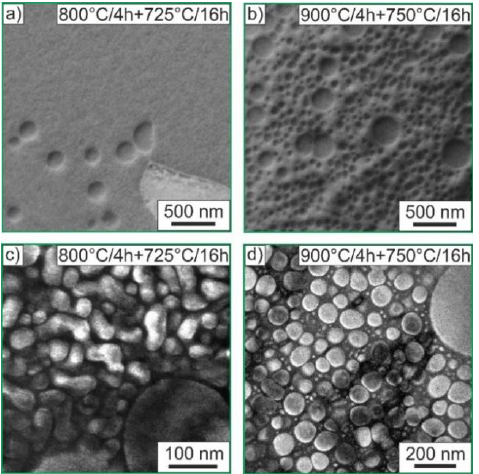
Figure 3. SEM images of the conditions after aging step II: ( a ) 800 °C/4 h + 725 °C/16 h and ( b ) 900 °C/4 h + 750 °C/16 h. Dark field TEM images of the conditions after aging step II: ( c ) 800 °C/4 h + 725 °C/16 h and ( d ) 900 °C/4 h + 750 °C/16 h.